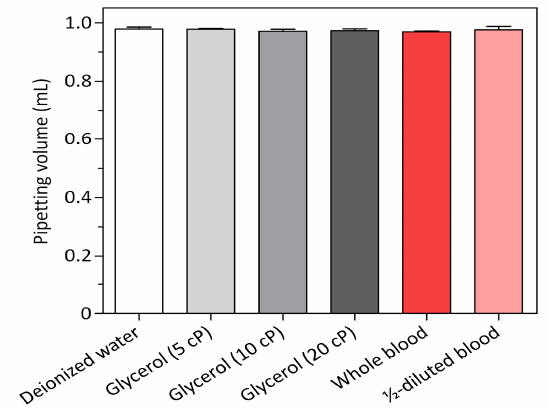
Figure 2. Volume-metering performance of the smart pipette. The embedded fixed-volume micropipette allows the delivery of a precise volume of various liquid samples into a microfluidic device ( n = 3).